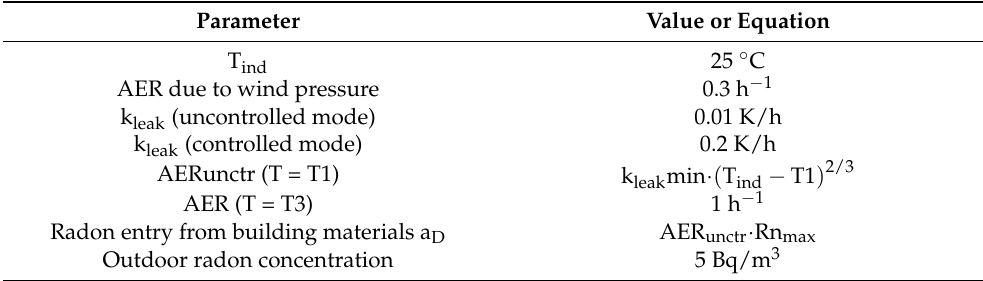
Table 6. Accepted parameters or the